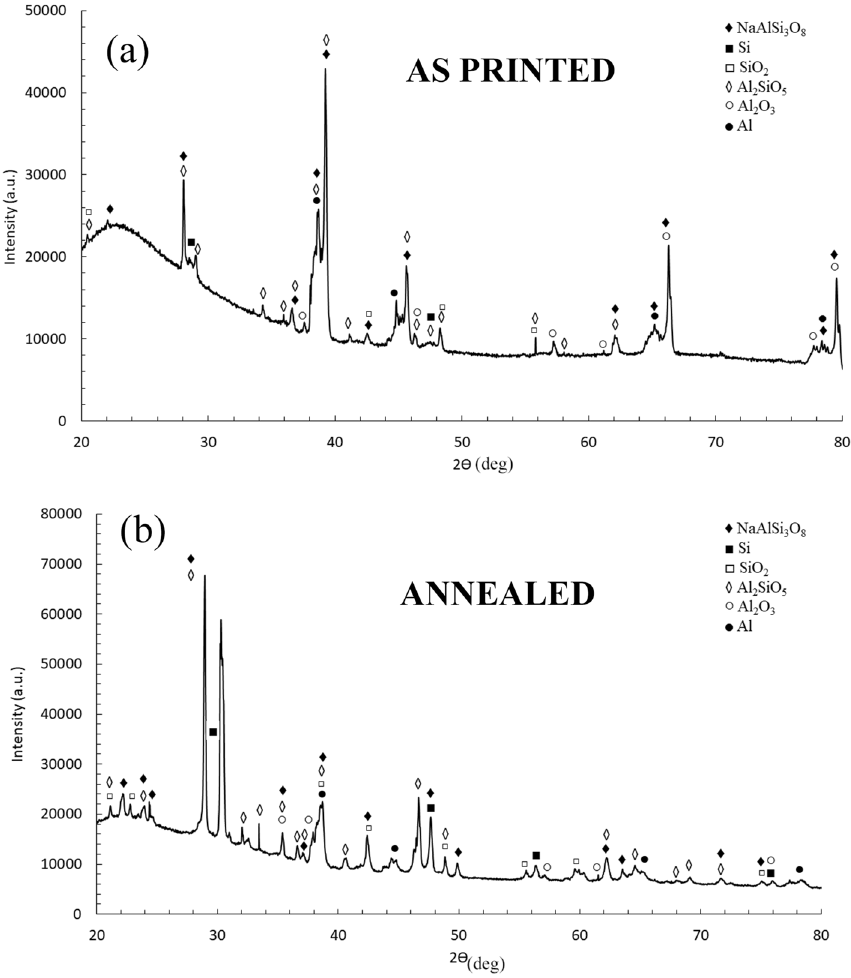
Figure 12. X-ray diffraction (XRD) pattern of PEO treated samples: As printed sample ( a ); annealed sample ( b